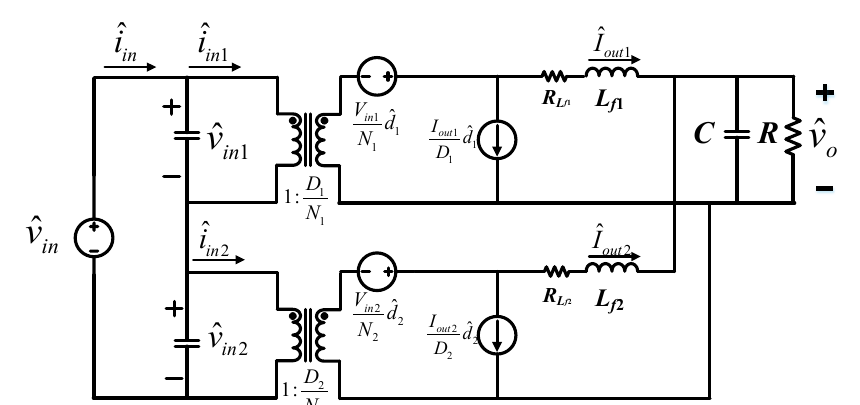
Figure 4. Configuration of ISOP converter.